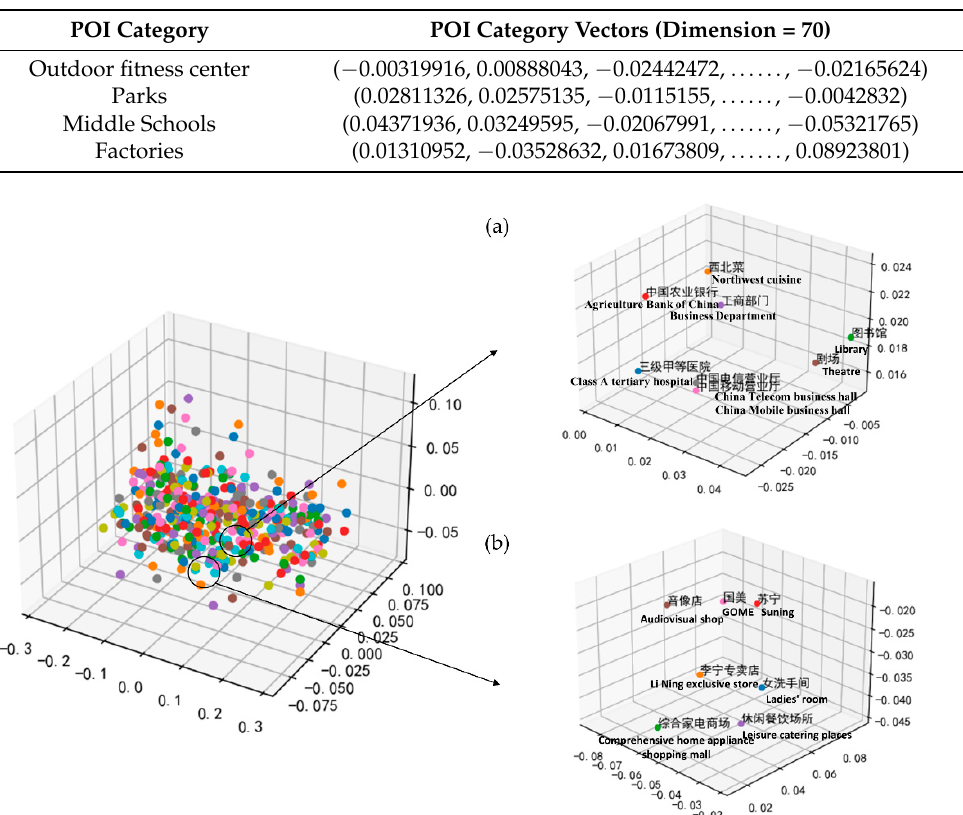
Table 3. Partial POI category vectors.